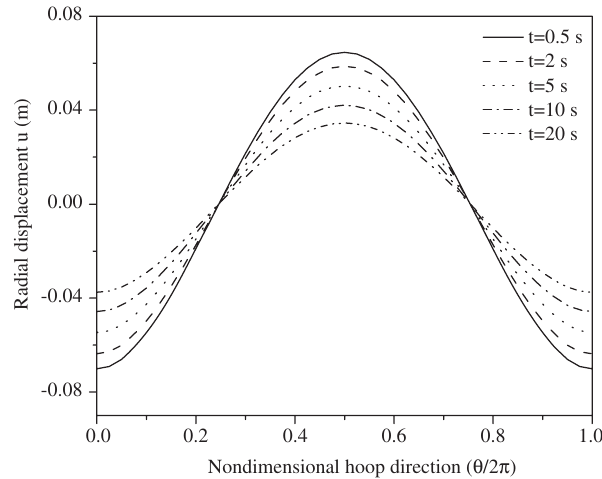
Figure 18 Distributions of temperature along the radial direction of the FGM hollow cylinder at different times.